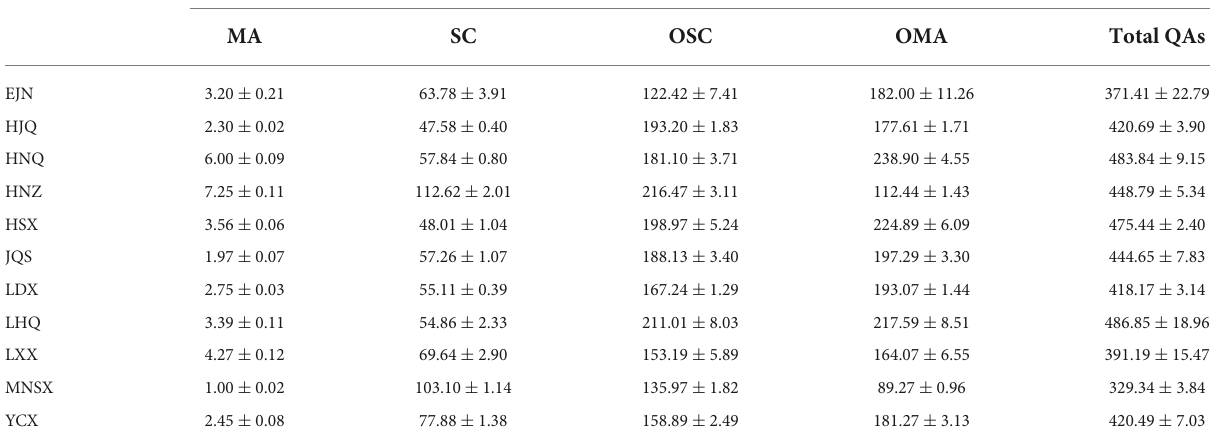
TABLE 2 Content of QAs in S. alopecuroides